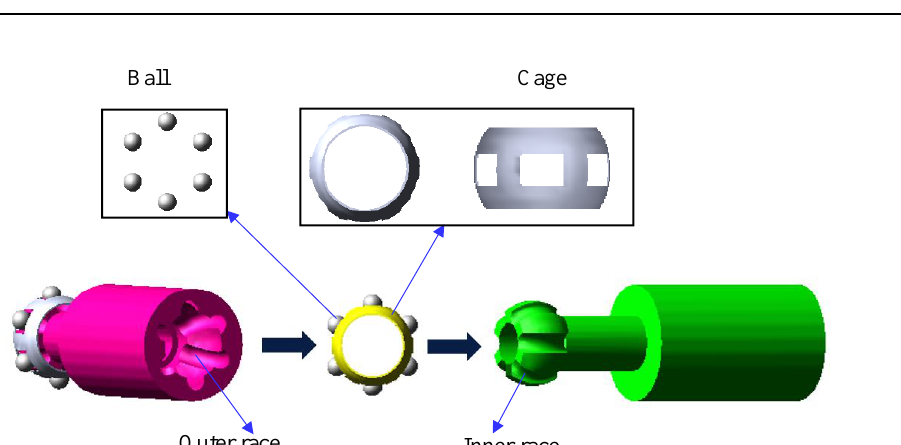
Figure 1. The structure components of BCFJ.